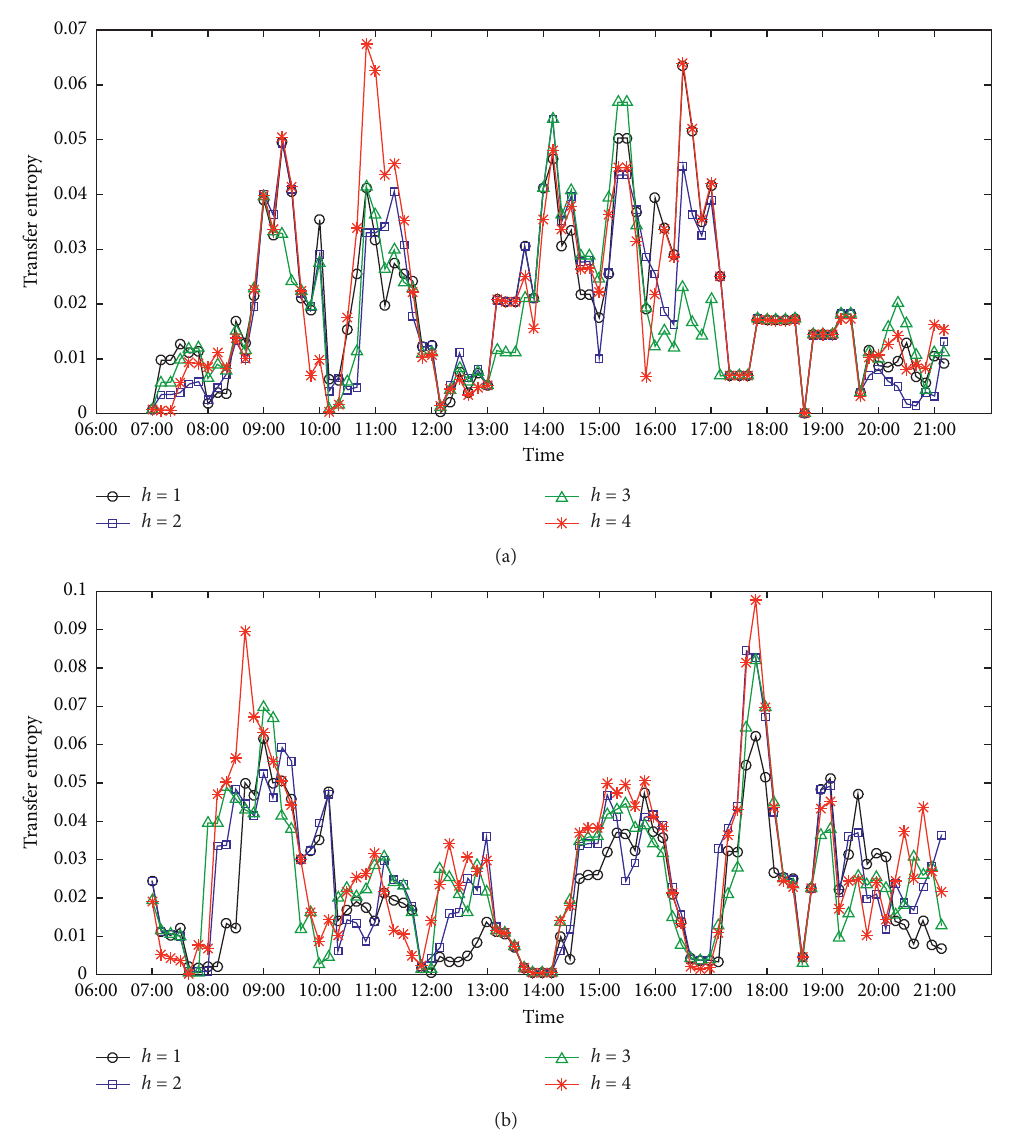
Figure 6: Variation of transfer entropy in different directions: (a) TE